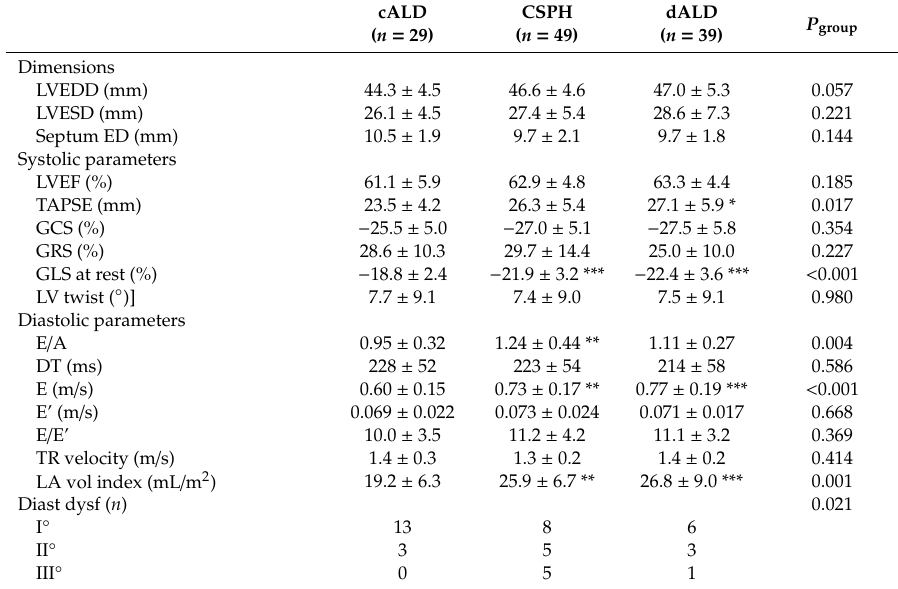
Table 2. Echocardiographic parameters at rest (mean +/ −